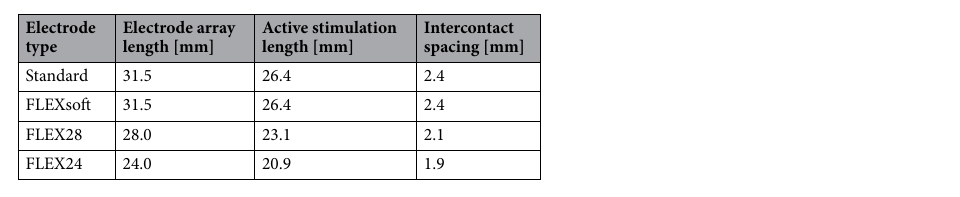
Table 2. Details of the different electrode types